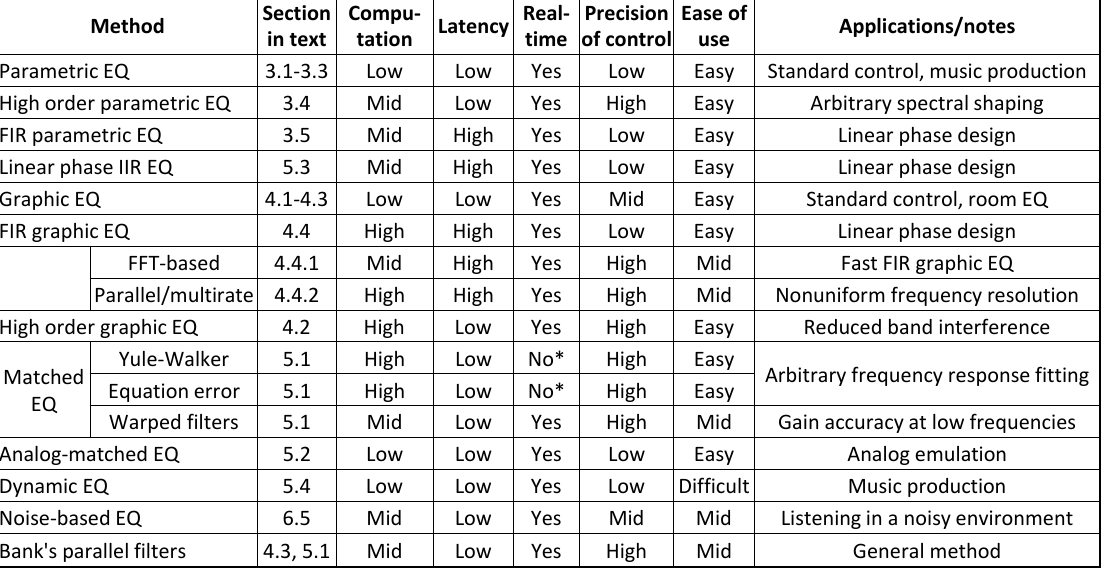
Table 3. A summary of approaches to equalization and their relevant features and applications. Note that Yule-Walker and the Equation Error method can be implemented in real-time if performed on a frame-by-frame